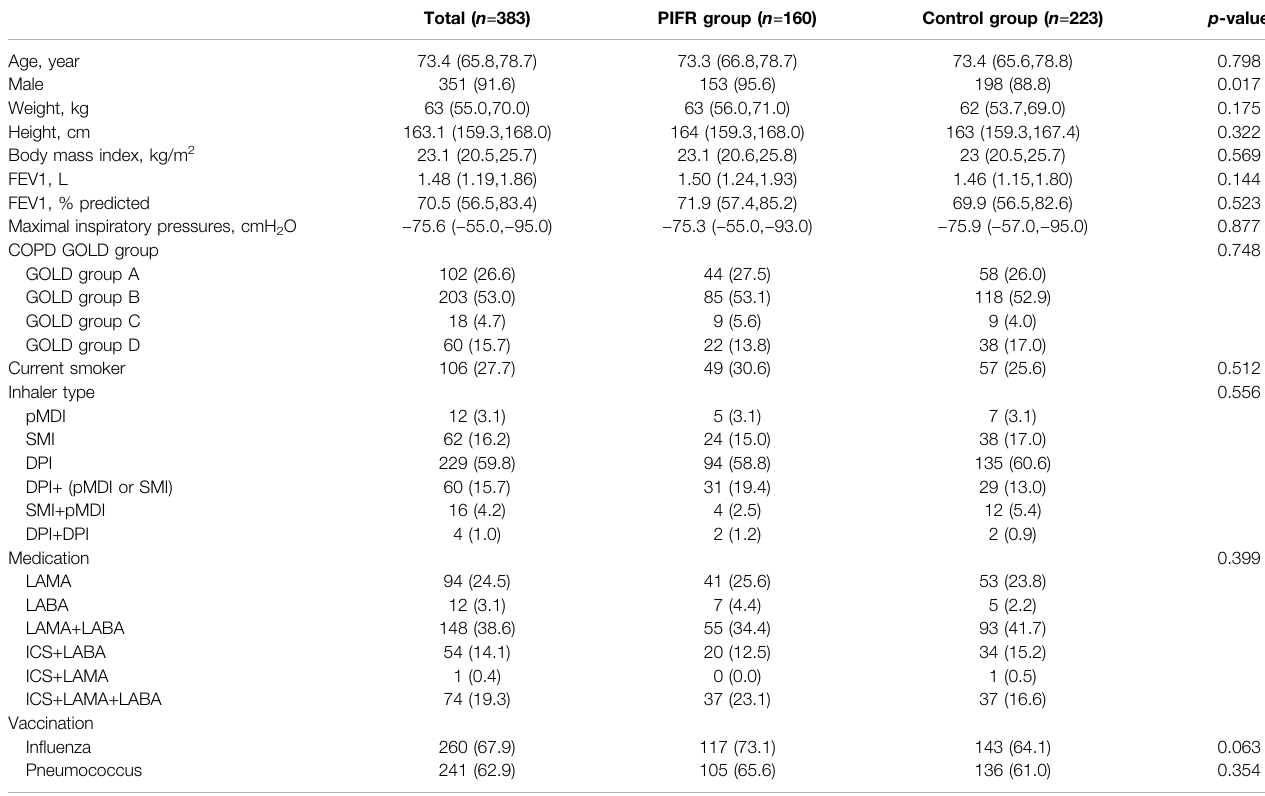
TABLE 1 | Baseline characteristics of the study subjects.